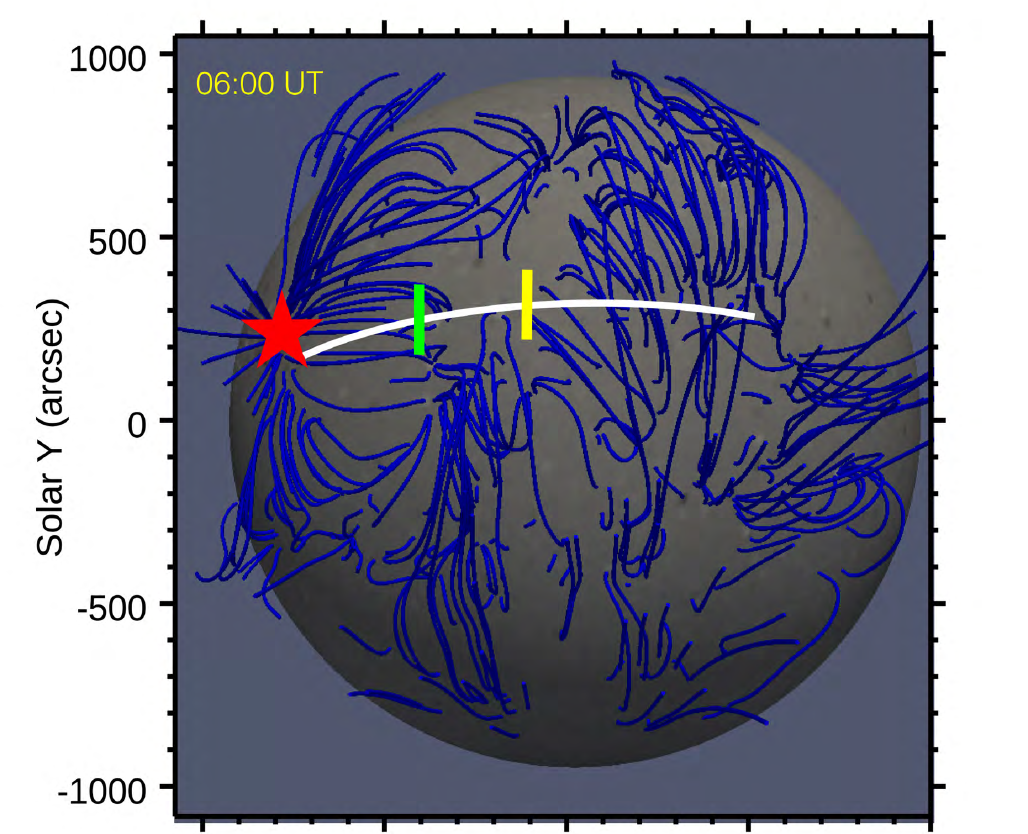
Figure 6. Extrapolated coronal magnetic field distribution on 6 May 2019 at 06:00 UT derived via the potential field source surface (PFSS) model. The green bar indicates the location where a single wave bifurcated into two waves at 05:12 UT as indicated by Figure 4d, and the yellow bar marks the location where the fast-mode outer EUV wave changes to a stationary front at 05:27 UT in Figure 4d. The active region is represented by the red star. The white line is the slice S 3 drawn in Figure 4a for the time-distance analysis of the wave